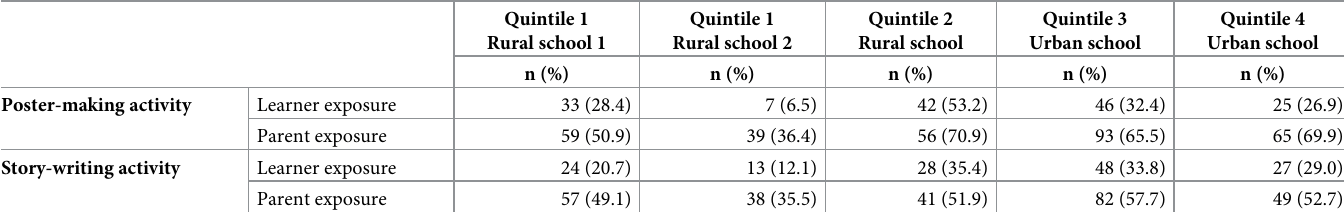
Table 4. Penetration and exposure by reinforcement activities and by